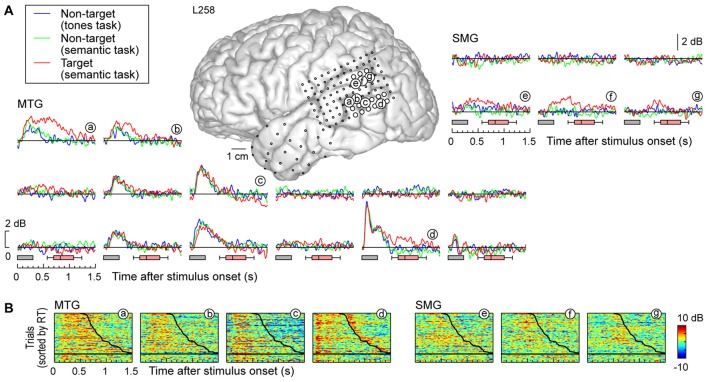
High gamma responses recorded from left MTG and SMG in subject L258. (A) Average high gamma ERBP waveforms. (B) Single-trial high gamma waterfall plots. See legend of Figures 3A,B for details.